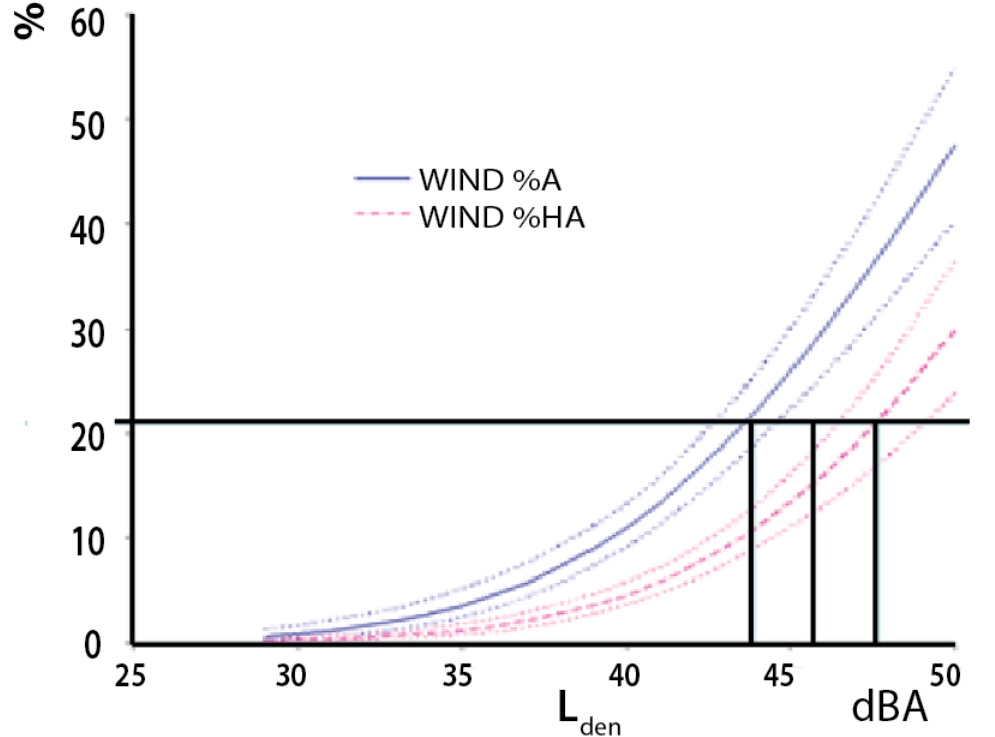
Figure 10. Exposure–effect relationships for wind turbine noise annoyance when outside the dwelling Janssen et al. [3]. (21%-line and drop-lines added by us). This figure is reproduced with the permission of Acoustical Society of